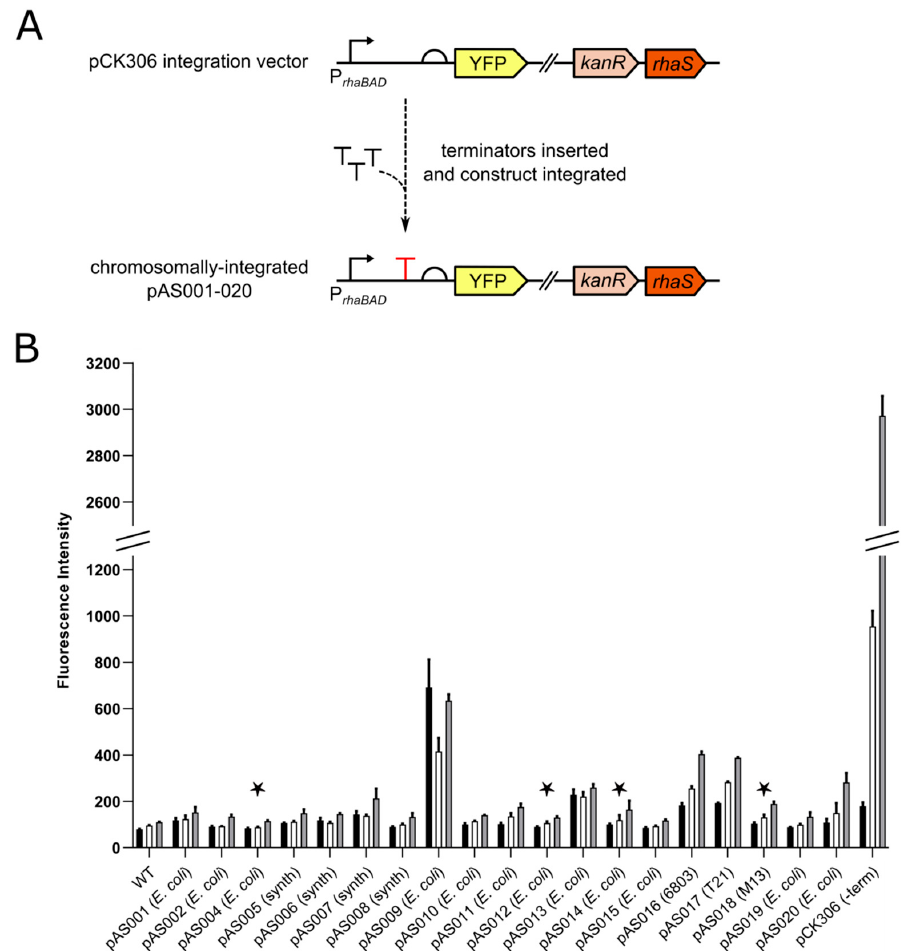
Figure 1. Screening of terminators in Synechocystis . ( A ) Overview showing insertion of terminators into plasmid pCK306 between the rhaBAD promoter and the ribosome-binding site (RBS) of the yellow fluorescent protein (YFP)-encoding gene. The resulting terminator constructs pAS001, pAS002, pAS004–020 were integrated into the Synechocystis genome. ( B ) Synechocystis transformants